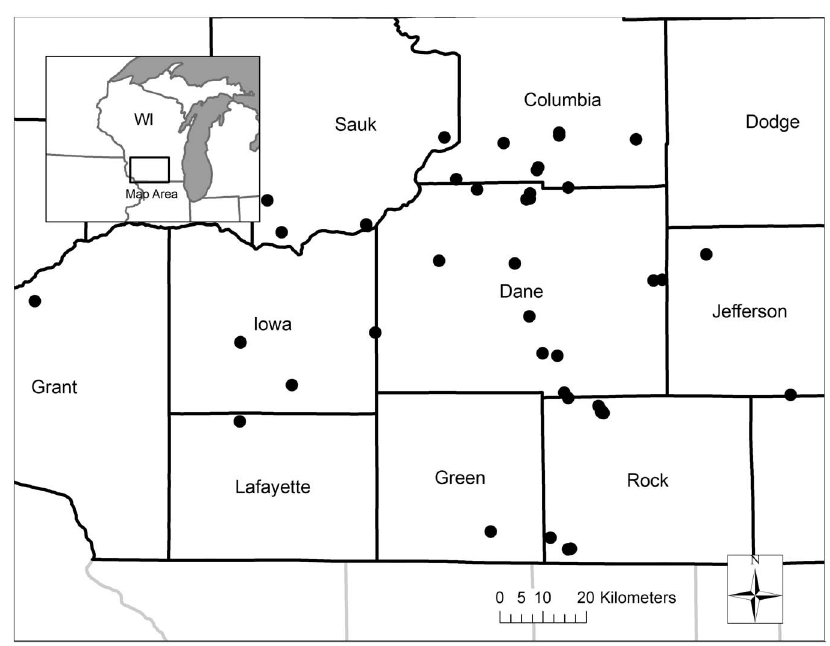
Figure 1. Study sites (solid circles) and counties in southern Wisconsin, USA.